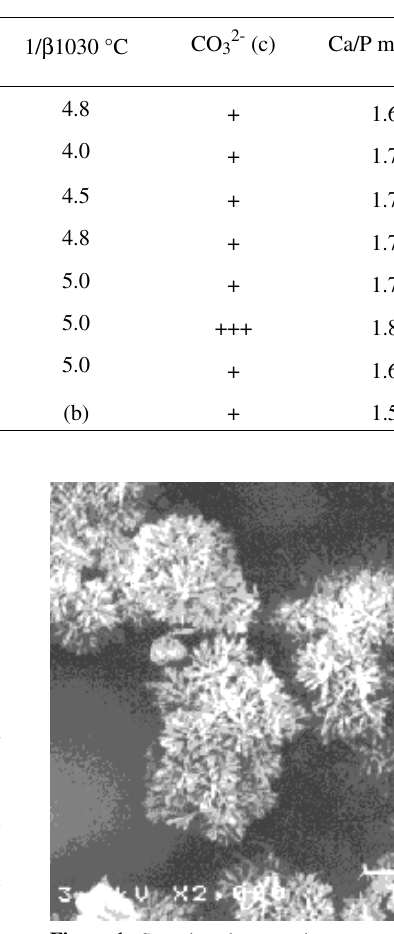
Figure 1. Scanning electron microscopy of HAP from experiment 0.